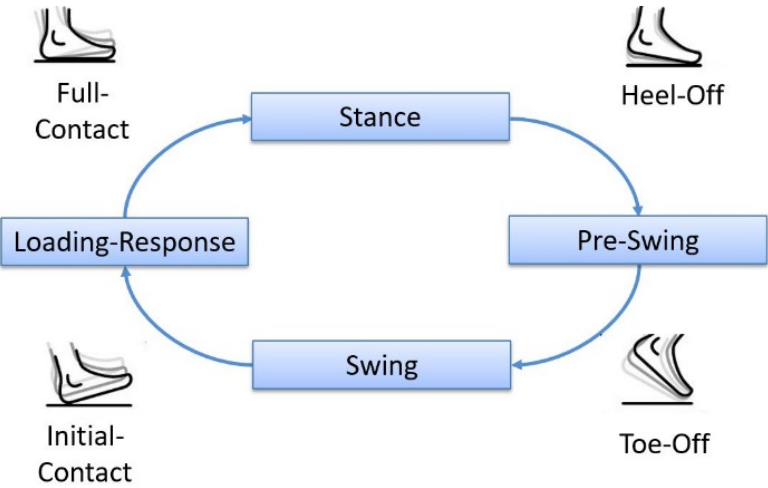
Figure 4. Finite-state diagram of gait events, adapted from [24].